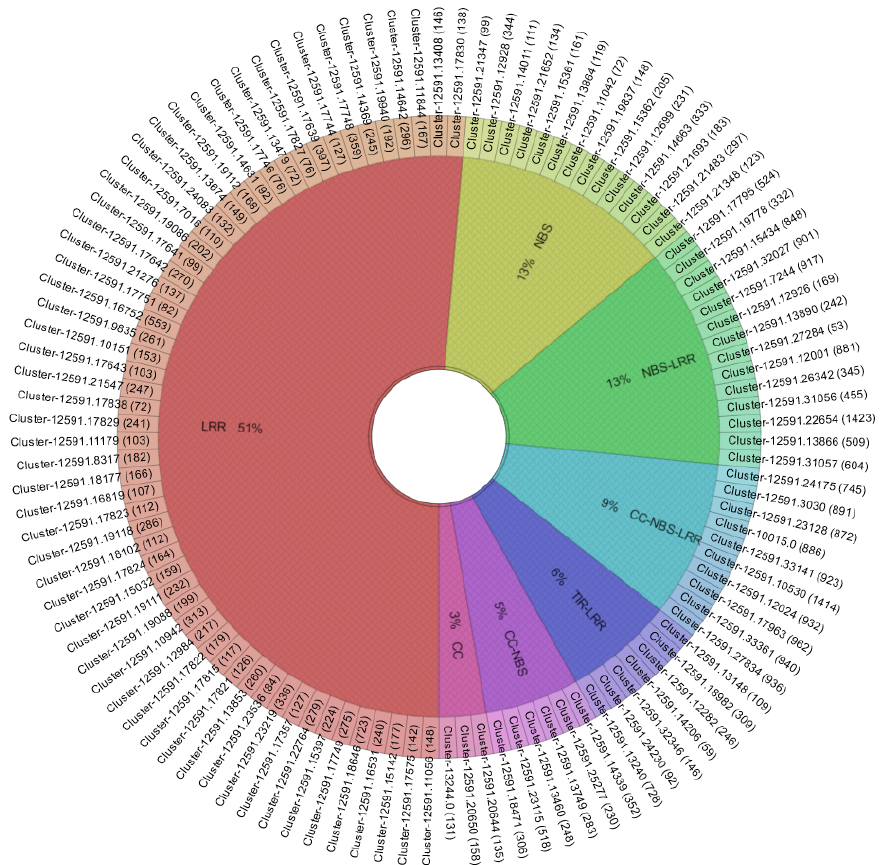
Figure 1. Distribution of predicted conserved domains in 111 unigenes related to BRV pathogenesis in R. nigrum cv. Aldoniai. The length of the sequences of amino acids is indicated in brackets, and amino acid sequences of unigenes are provided in Table S1.